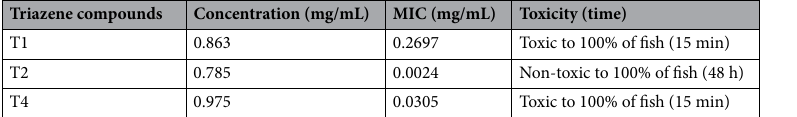
Table 9. Ecotoxicity test results; concentrations of the triazene compounds used in the fish test, MIC, and toxicity classification. Toxicity parameter: Caused fish death. Non-Toxic: Did not kill the fish. MIC: Minimum inhibitory